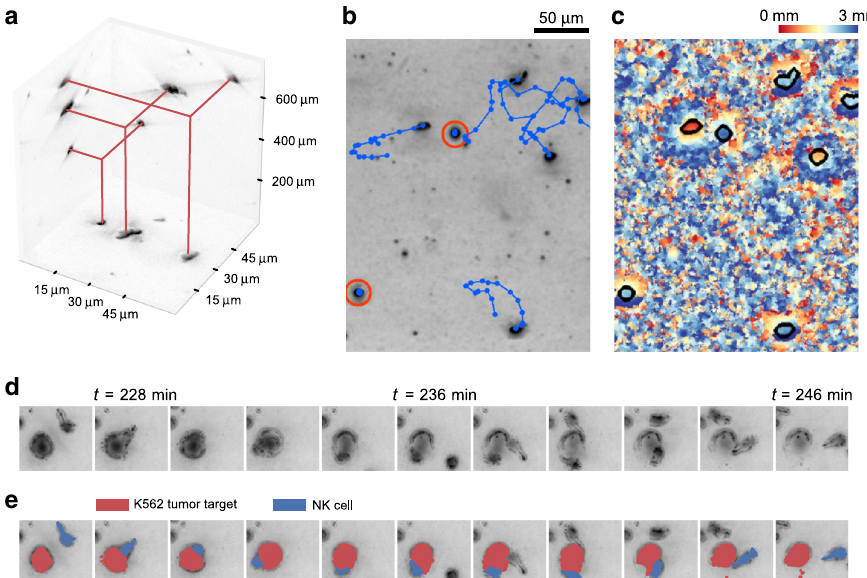
Fig. 2 NK cell motility assay and cytotoxicity assay in a 3-D collagen gel. a Minimum intensity projections along the x / y / z -axes of a bright- fi eld image stack of NK cells migrating through a 3-D collagen gel. In the projections, the NK cells appear as dark spots. b Exemplary minimum intensity projection along the z -axis, taken from one out of ten similar, independent experiments. Cell trajectories over 30 min are indicated in blue, nonmotile cells are marked red (scale bar: 50 µ m). c False-color representation of the z -position of every pixel in the minimum projection. This information is used to estimate the z -position of motile NK cells (cell outlines are indicated in black). d Time-lapse image sequence of an NK cell-mediated killing of a K562 tumor cell, taken from one out of six similar, independent experiments. e Same as d , with colored cell morphologies as a guide for the eye.